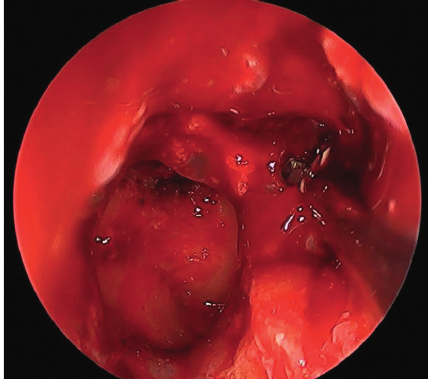
Figure 9: Postoperative debridement and complete removal of fungal balls from both left maxillary and sphenoid